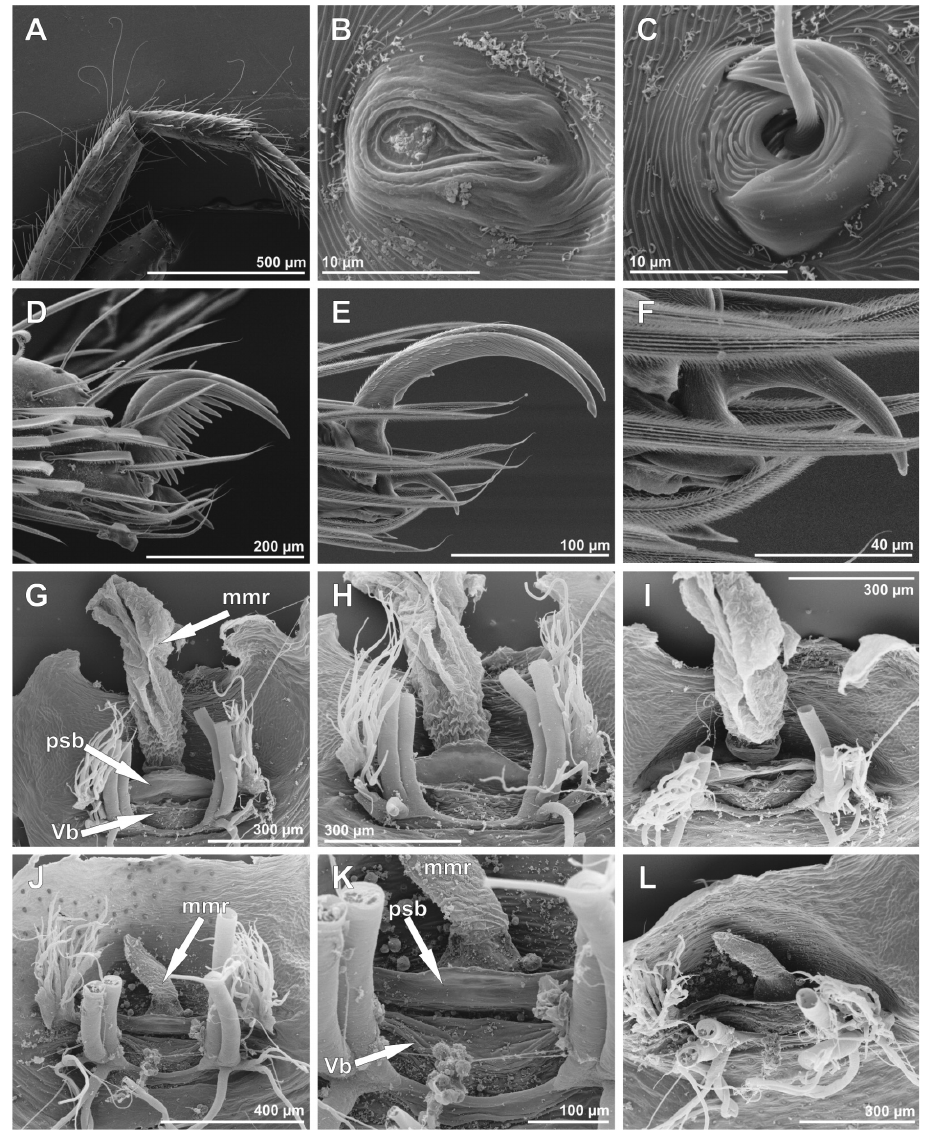
Figure 3. SEM images of Tisentnops mineiro sp. n., female (IBSP 191301) ( A – I ), female (IBSP 191297) ( J–L ). A right tibia, metatarsus and tarsus I, prolateral view B tarsal organ on leg I, dorsal view C tri- cobothrial base on leg I, dorsal view D claws on left tarsus I, prolateral view E claws on left tarsus IV, prolateral view F same, detail unpaired claw, prolateral view G female internal genitalia, dorsal view H same, posterior view I same anterior view J same, dorsal view K same, detail of receptaculum, dorsal view L same, anterior view (mmr = membranous anteromedian receptaculum; psb = pair of sclerotized bars; Vb = V-shaped